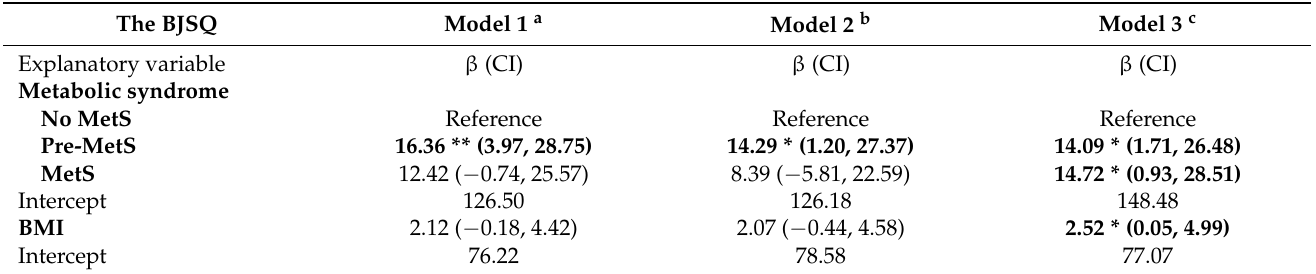
Table 4. The association between metabolic syndrome and body mass index, respectively, and the Brief Job Stress Questionnaire score in participants with low sleep satisfaction ( n = 83).